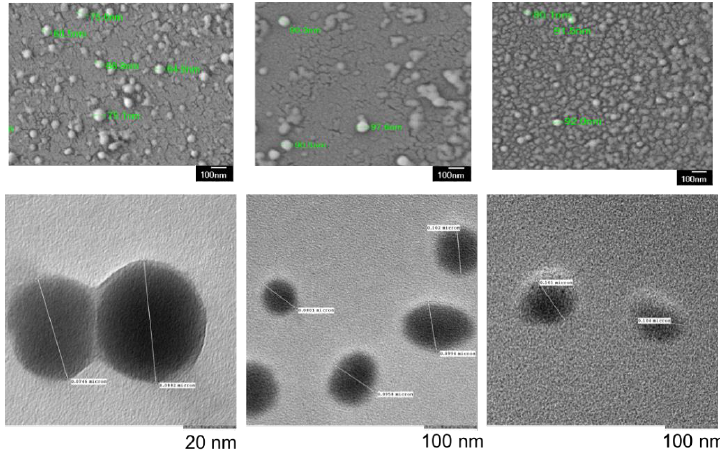
Figure 2. SEM ( top ) and TEM ( bottom ) images of EMPTY mPEG-PLGA ( left ), BPD ( middle ) and CED ( right ) NPs show uniform size distribution and spherical morphology. Empty NPs were slightly smaller than drug loaded NPs. Size measurements complemented DLS results. Small differences in size compared to DLS were attributed to dehydration of NPs during preparation for SEM and TEM. Scale bar: 100 nm.